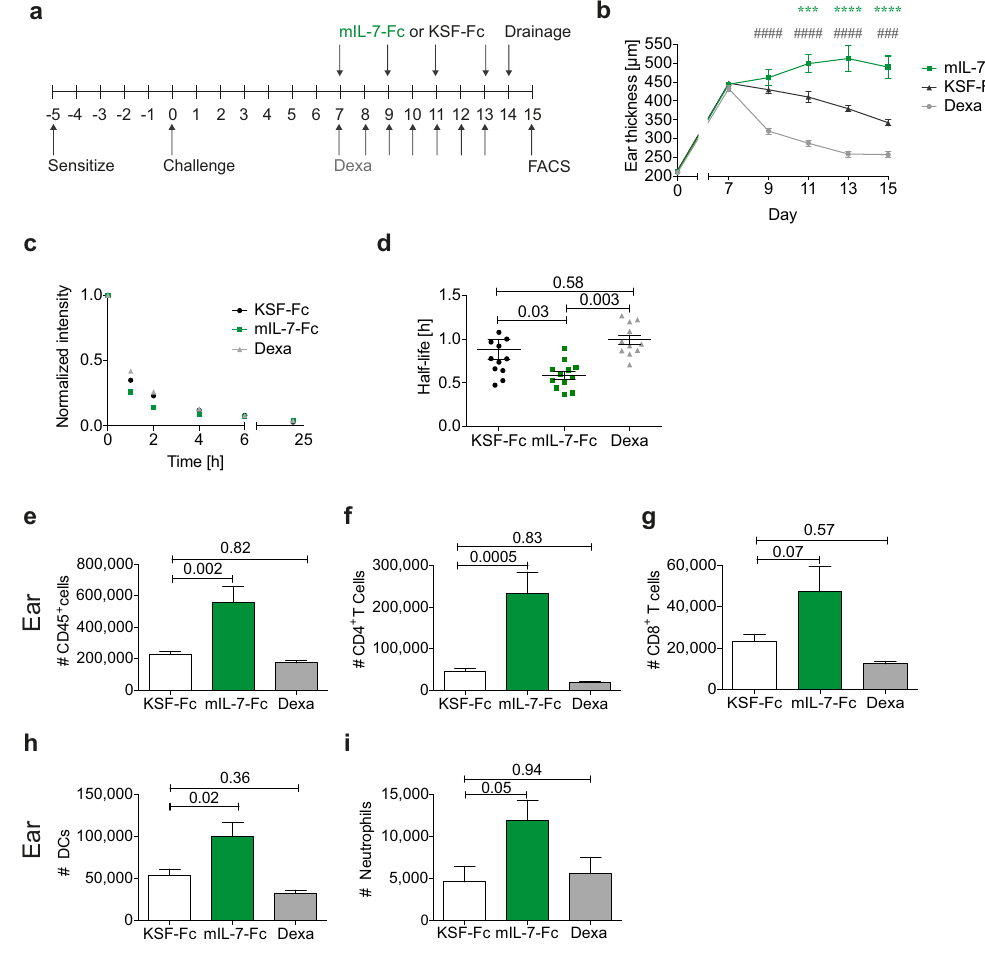
Figure 2. mIL-7-Fc treatment exacerbates oxazolone-induced inflammation in K14-VEGF-A mice in spite of increasing lymphatic drainage. ( a ) Hemizygous K14-VEGF-A mice were sensitized with oxazolone on the belly and paws. Five days later the ears were challenged with oxazolone. Mice were randomized into treatment groups of comparable ear thickness on day 7 and treated i.p. with mIL-7-Fc, KSF-Fc every second day, or with dexamethasone (Dexa) every day for one week. The ear thickness was measured on each treatment day. Lymphatic drainage was measured on day 14 after challenge, and the mice were sacrificed on day 15. Immune cell infiltration in the ear skin was analyzed by FACS. ( b ) Ear thickness measurements over the course of the treatment. P values indicated by an asterisk show comparisons between mIL7-Fc and KSF-Fc, and p values indicated by a pound sign show comparisons between Dexa and KSF-Fc. ###/ *** p < 0.001; ####/ **** p < 0.0001. ( c , d ) Lymphatic drainage analysis: ( c ) Average clearance plots of P20D800 measured by IVIS and ( d ) the calculated half-lives. FACS-based quantification of the number of ( e ) CD45 + cells, ( f ) CD4 + T cells, ( g ) CD8 + T cells, ( h ) DCs, ( i ) neutrophils in the ear skin on day 15. One ear per mouse was used for the FACS analysis. Pooled data (mean ± SEM) from 2 similar experiments with a total of 11–12 mice per group are